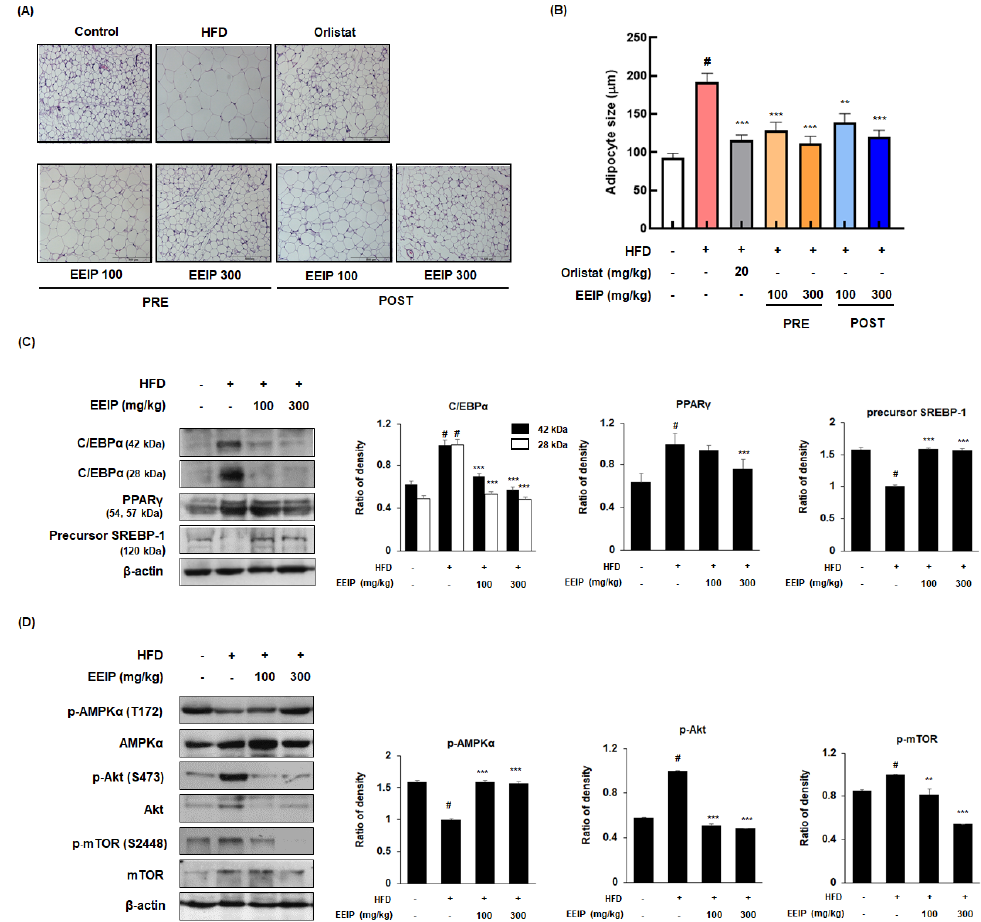
Figure 6. Effects of EEIP on adipocyte size and the levels of adipogenic−related proteins in the subcutaneous fat tissue of HFD−fed obese mice. ( A ) H&E-stained images of subcutaneous adipose tissues. ( B ) The adipocyte diameter was measured through microscopic analysis. ( C , D ) Adipogenic−related protein expression was determined by Western blotting analysis and β − actin was used as the internal control. Densitometric analysis was performed using Bio−Rad Quantity One Software (BioRad; Hercules, California, USA). Values are represented as the mean ± SEM. # p < 0.05 vs. normal diet control group; ** p < 0.01 and *** p < 0.001 vs. HFD group.